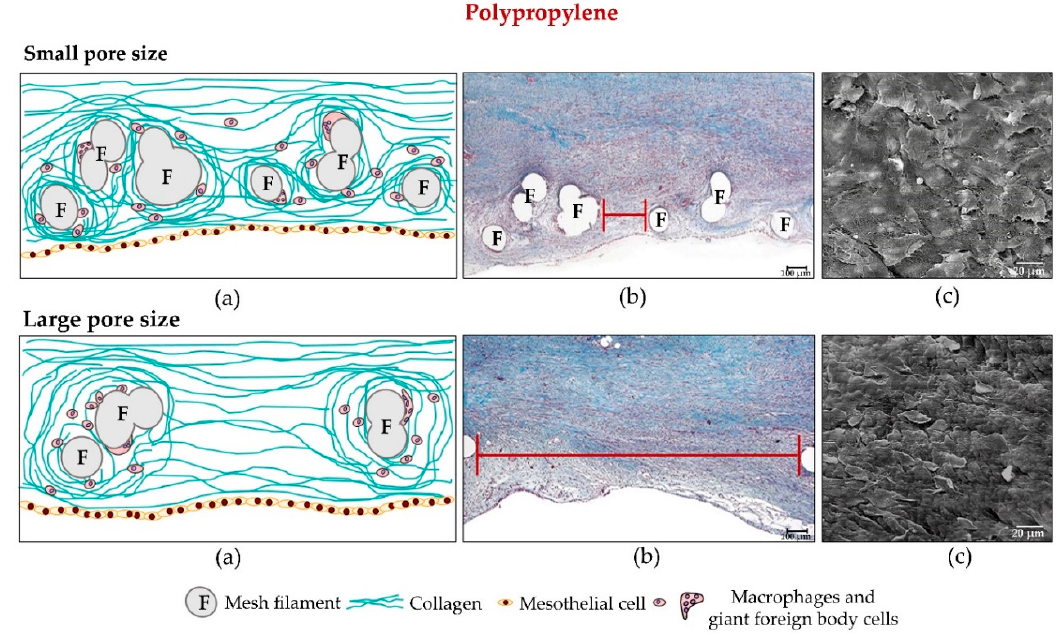
Figure 3. ( a ) Diagrams and ( b ) light microscopy images (100×) showing tissue incorporation (cross-section) in polypropylene meshes, once implanted in the abdominal wall (90 days post-implant). The prosthetic filaments are surrounded by scar tissue in which the collagen fibres concentrically lay around the mesh filaments. The spaces between filaments are also occupied by scar tissue. Scale bar: 100 μ m. ( c ) Scanning electron microscopy view of mesothelial covering (14 days, 500×). Scale bar: 20 μ m.